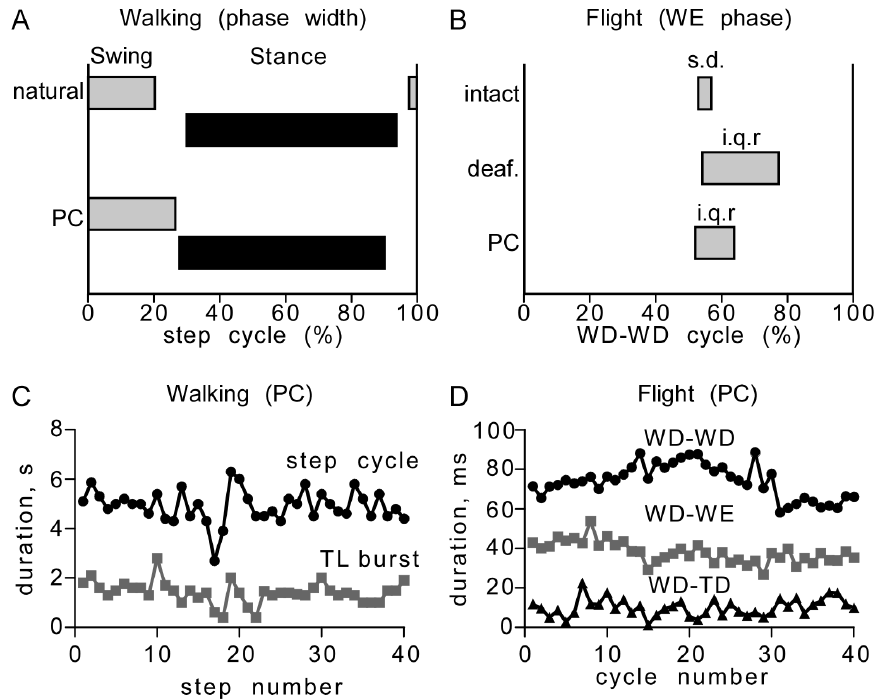
Figure 2. A general comparison of natural and pharmacologically induced walking and flight motor activity in intact and deafferented locusts. A Walking. Bars giving the start and end of the swing (grey) and stance (black) phases within the step cycle. Top (natural): data for naturally occurring, free walking from [34] (means of the activity of two antagonistic coxal muscles). Bottom (PC): Pilocarpine (1 mM) induced fictive walking (this paper, medians of 19 animals, 15 cycles each). B Flight. Bars giving the range of the phase of wing elevator (WE) units in the depressor cycle (WD-WD). Top (natural): Standard deviation (s.d.) of phase for intact tethered flying locusts from [35]. Middle (deaf.): Interquartile range (i.q.r.) of phase for wind-induce fictive flight of deafferented locusts (this paper, 35 animals, 100 cycles each). Bottom (PC): Interquartile range (i.q.r.) of phase for pilocarpine (1 mM) induced fictive flight of deafferented locusts (this paper, 19 animals, 100 cycles each). C, D Sequential plots comparing pilocarpine (PC, 1 mM) induced fictive walking and fictive flight respectively. C Step cycle length (black circles) and duration of the TL burst (grey circles) for 40 step cycles over a 3 min period. D Wing depressor cycle length (WD-WD, black circles), wing depressor-elevator latency (WD-WE, grey squares) and wing depressor-trochanteral depressor latency (WD-TD, black triangles) for 40 fictive flight cycles over a 3 s interval.